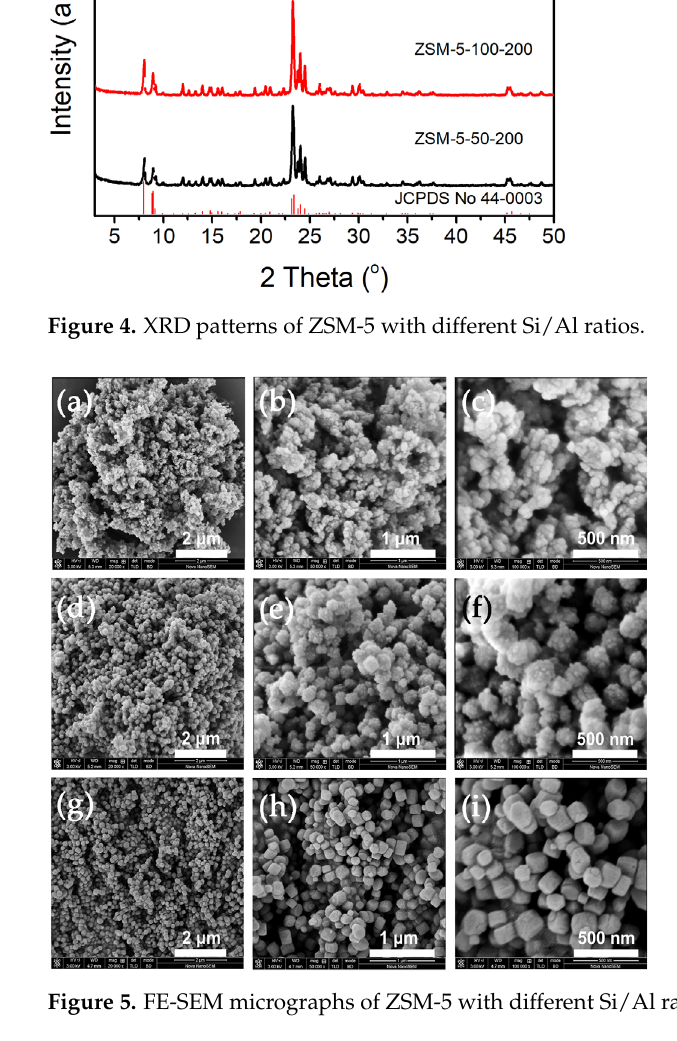
Figure 5. FE-SEM micrographs of ZSM-5 with different Si/Al ratios: ( a – c ): 50; ( d – f ): 100; ( g – i ): 150. Figure 5. FE ‐ SEM micrographs of ZSM ‐ 5 with different Si/Al ratios: ( a – c ): 50; ( d – f ): 100; ( g – i ): 150.